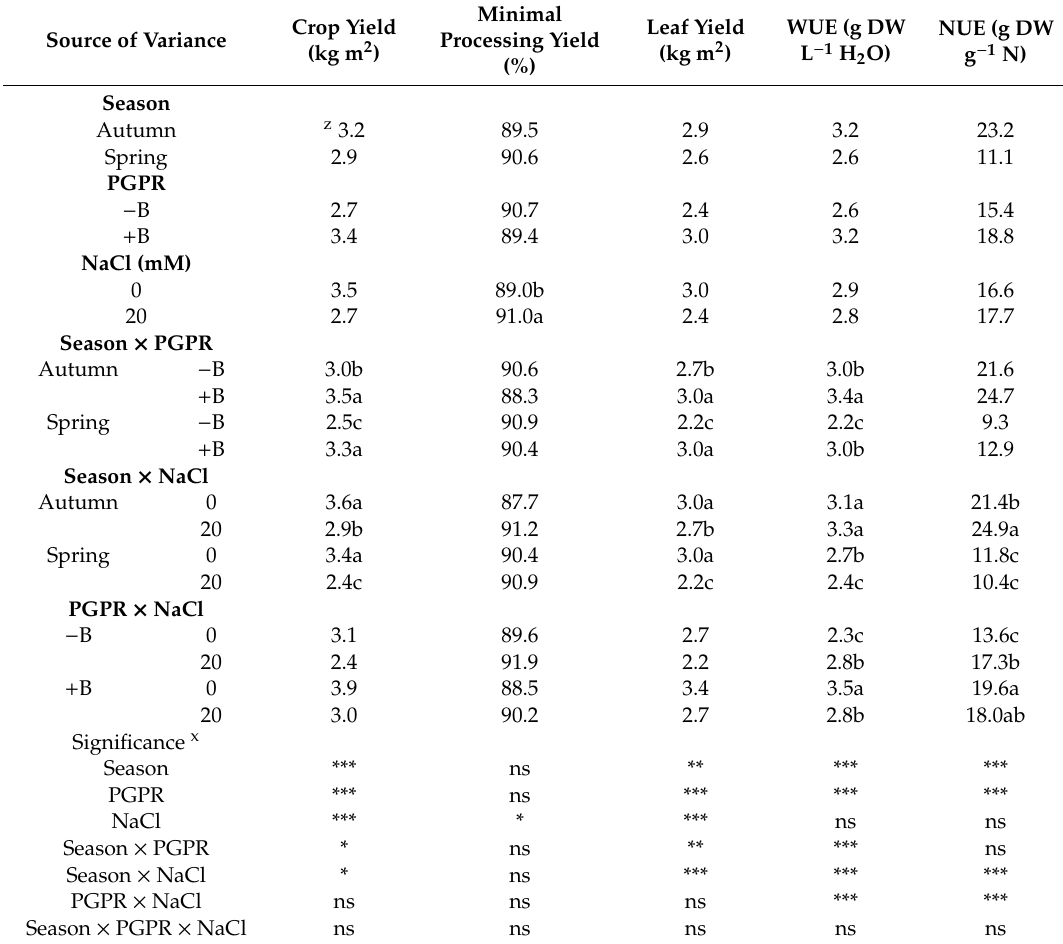
Table 2. Yield parameters of leaf lettuce plants grown during autumn and spring in nutrient solutions containing di ff erent levels of NaCl and bacterial